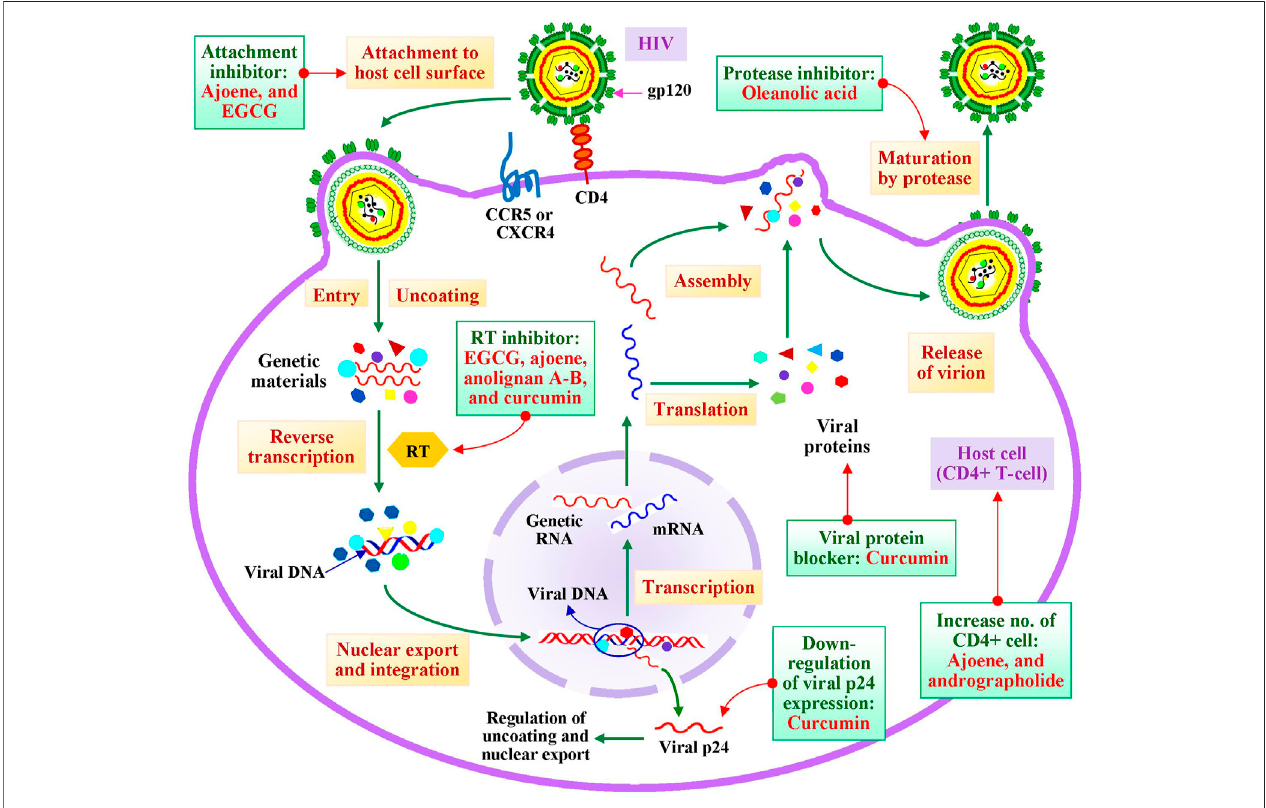
FIGURE 2 | Impact of bioactive metabolites derived from Bangladeshi medicinal plants on molecular targets of various steps of multiplication process of HIV. RT, reverse transcriptase; EGCG, epigallocatechin-3-gallate; and gp120, glycoprotein-120.